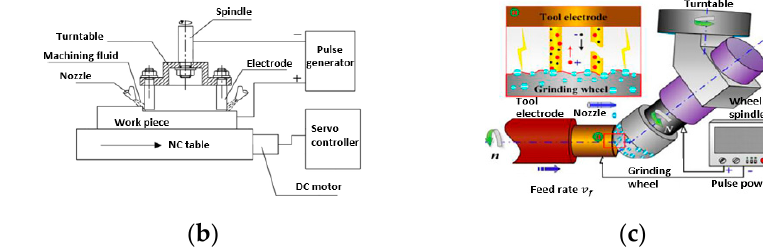
Figure 5. Different forms of electric discharge machining (EDM), ( a ) Wire EDM [82], ( b ) Electric discharge milling [83], ( c ) Electric grinding [84]. Copyright granted by Elsevier.